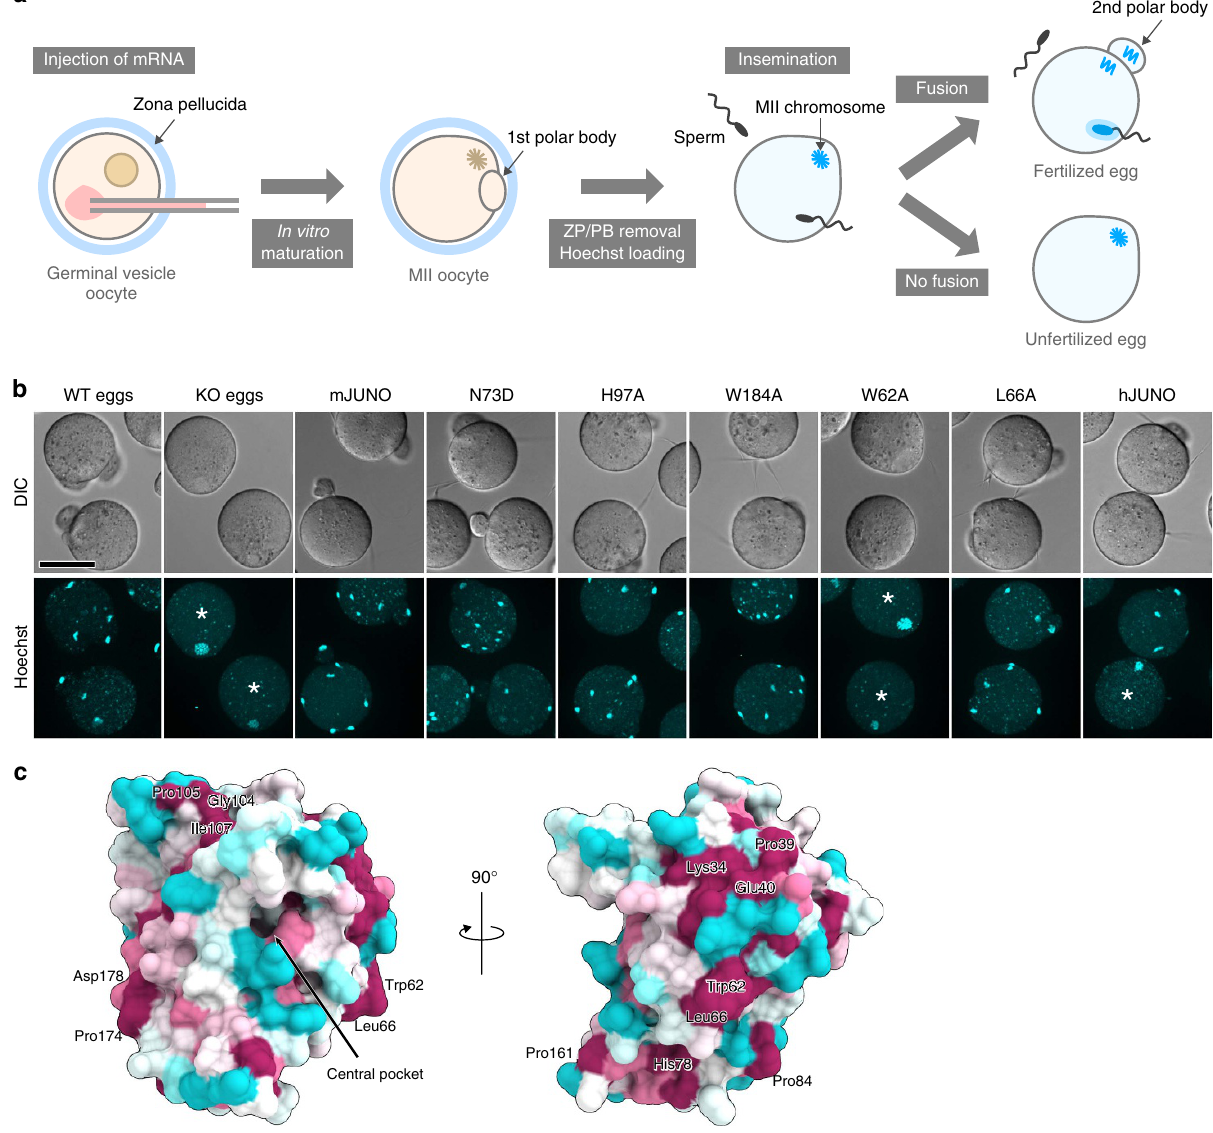
Figure 3 | IZUMO1-binding site. ( a ) Schematic showing the sperm–egg fusion complementation assay. After mRNA injection and in vitro maturation, Hoechst 33342 was loaded to visualize the MII chromosome and the fused sperm heads. ( b ) Functional complementation of Juno KO eggs by mRNA injection. The mRNA encoding the WTor mutants of mouse JUNO (mJUNO), or human JUNO (hJUNO), was injected into the mouse Juno KO eggs. The fusion of mouse spermatozoa was visualized by the transfer of DNA dye from the egg to the sperm nuclei. The extrusion of the second polar body was used as an indicator for successful fertilization. Asterisks indicate unfertilized eggs. Scale bar, 50 m m. ( c ) Conservation of the surface residues of the N73D mutant JUNO. The sequence conservation among JUNOs from 14 mammalian species (human, monkey, gorilla, chimpanzee, elephant, pig, horse, bear, cat, rabbit, golden hamster, mouse, rat and opossum) was calculated using the ConSurf server (http://consurf.tau.ac.il), and is coloured from cyan (low) to maroon eluted with the buffer supplemented with 300mM imidazole. To cleave the C-terminal His tag, the eluted protein was mixed with the HRV3C protease and dialysed against buffer, consisting of 20mM Tris-HCl, pH 7.5, 150mM NaCl and 20mM imidazole, at 4 (cid:2) C overnight. The protein was passed through the Talon column again, and further purified by chromatography on Mono Q (GE Health- care) and Superdex 200 columns (GE Healthcare). The purified N73D mutant JUNO protein was concentrated to 5mgml (cid:2) 1 , using an Amicon Ultra-4 filter (10kDa molecular-weight cutoff; Millipore). Crystallography . The purified N73D mutant JUNO protein was crystallized at 20 (cid:2) C by the sitting drop vapour diffusion method. The crystals were obtained by